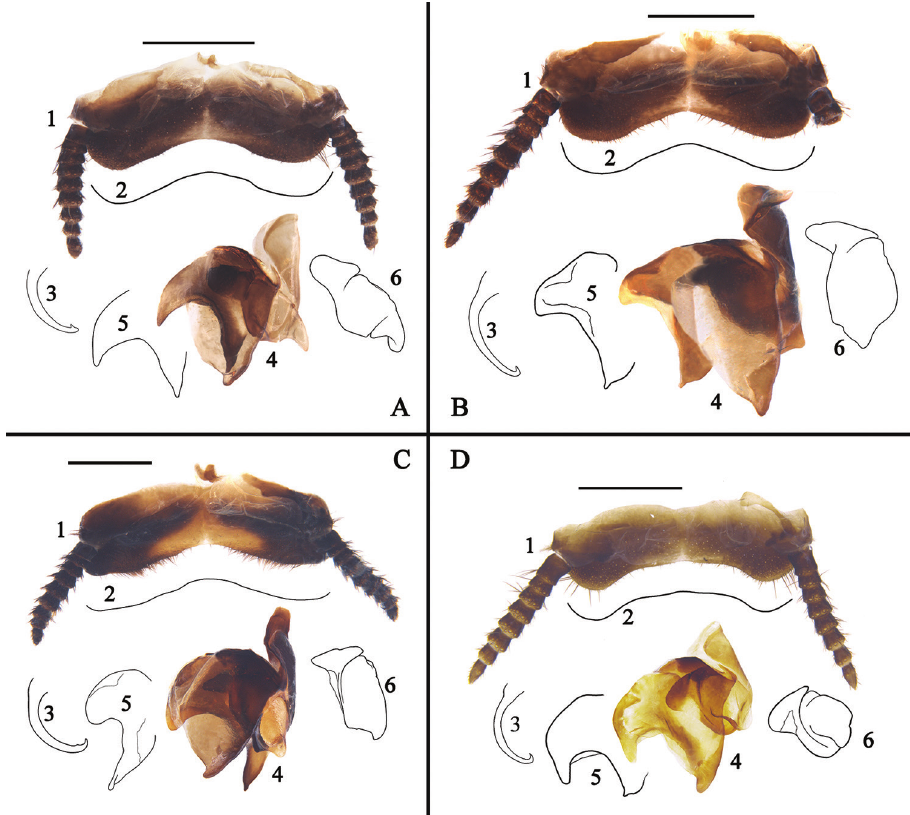
Figure 8. A–D Features of Eucorydia species (supra-anal plate ( 1 ), hind margin of supra-anal plate ( 2 ), genital hook/L3 ( 3 ), right phallomere with L7 ( 4 ), appendage sclerite/L7 ( 5 ), R2 ( 6 )) A E. linglong sp. n. B E. yunnanensis C E. pilosa sp. n. D E. guilinensis sp. n. Scale bars 1